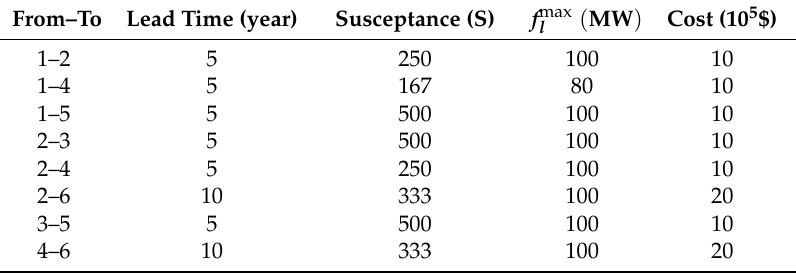
Table 2. Branch data.